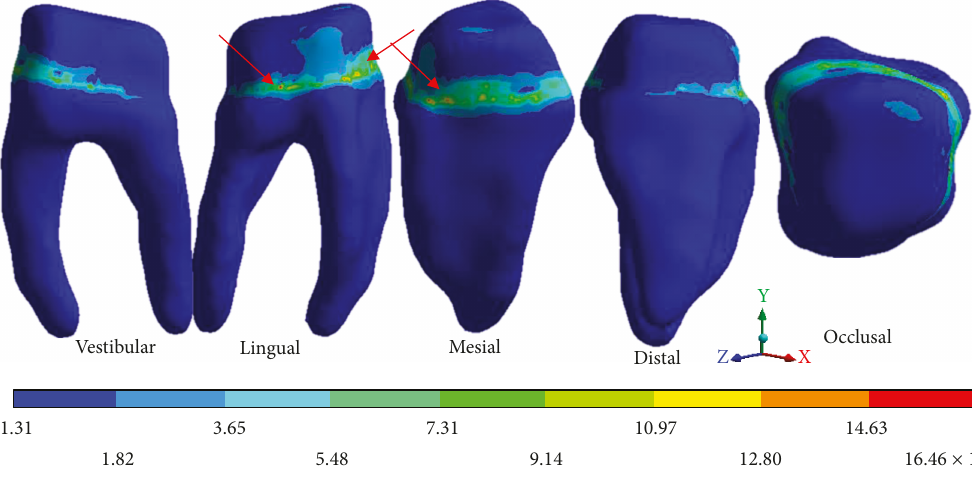
Figure 10: 1st degree caries : von Mises stresses in dentin.